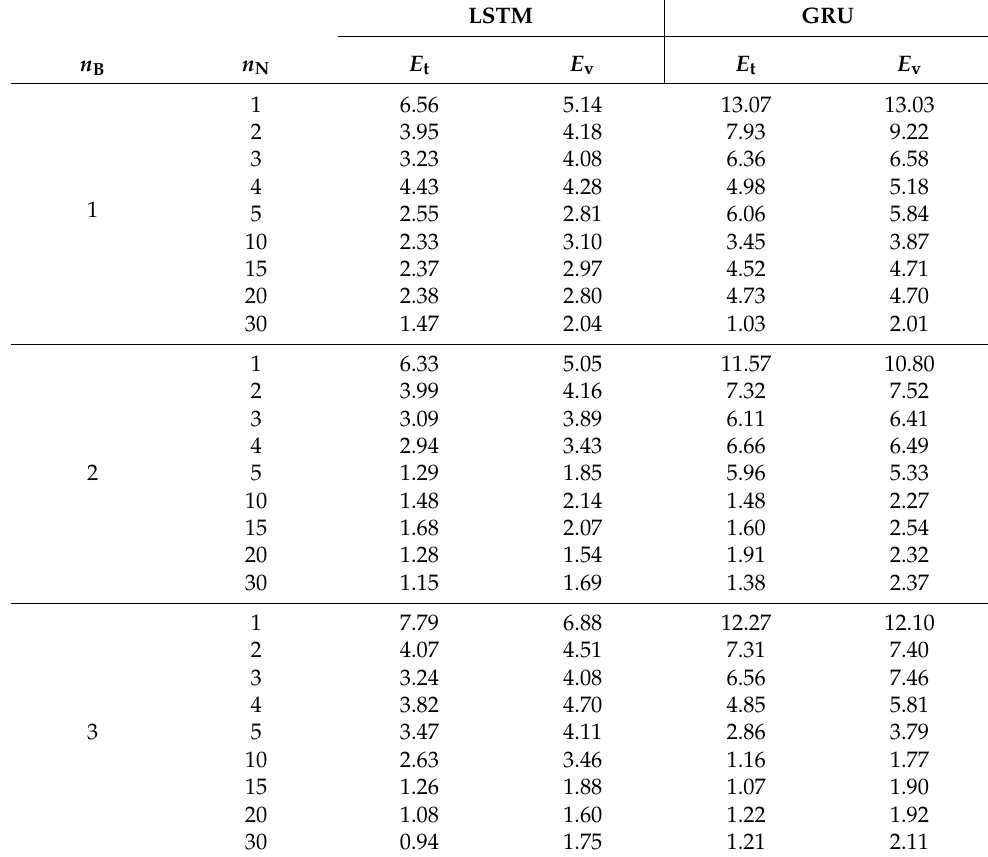
Table 3. The neutralisation reactor: comparison of selected LSTM and GRU networks without the recurrent inputs ( n A = 0) in terms of the training ( E t ) and validation errors ( E v